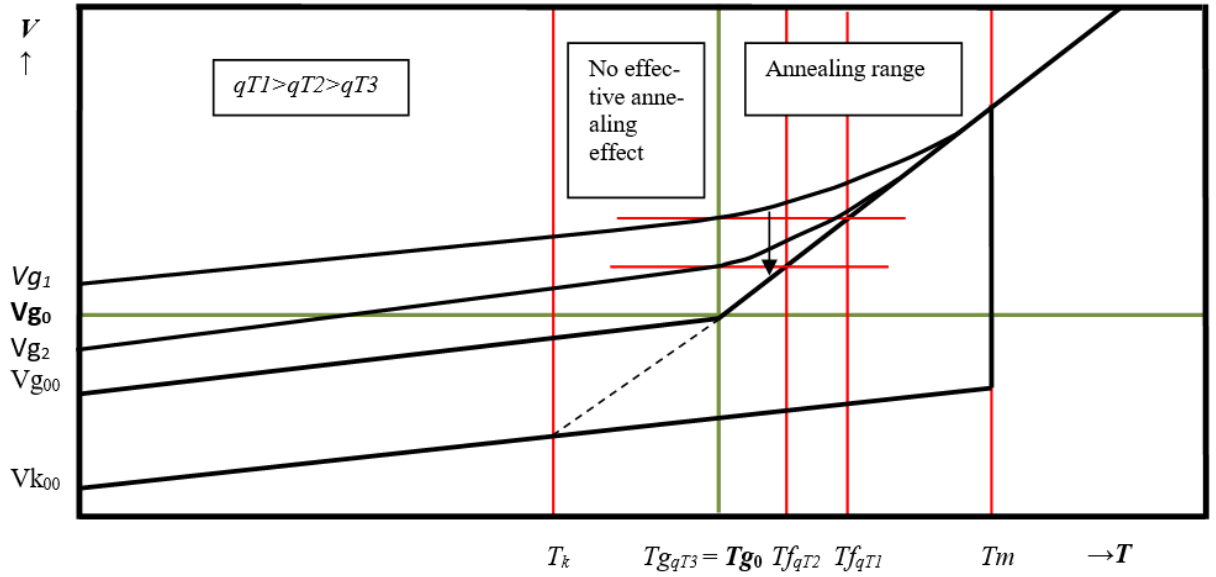
Figure 5. Time-dependent development of the specific volume (schematic). qT1 , qT2 , and qT3 are three different cooling rates, the first being the fastest. With qT3 the rate approaches zero and Tg qT → 0 = Tg 0 . At Tg 0 , the lowest achievable specific volume Vg 0 is reached for a completely disordered material. The path along the dashed line in the direction of T k is not feasible with unaligned molecular axes but only in the (partially) crystalline state. The red horizontal lines yield at their intersections with the equilibrium volume line the fictive temperatures of the obtained glasses with their respective cooling rates. The black downward pointing arrow demonstrates the possibility of reaching a denser glass by annealing. The closer the temperature is to Tg 0 (and the higher the viscosity), the longer the annealing time.